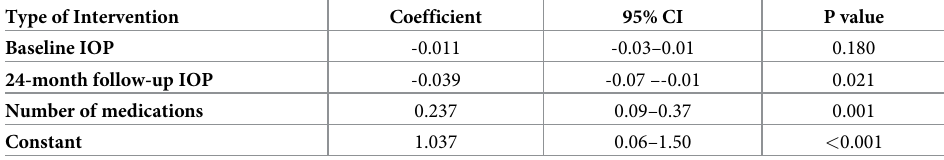
Table 4. Results of multivariable random coefficient model analysis of type of intervention, baseline IOP and 24-month follow-up IOP, including the covariable of number of medications. Type of